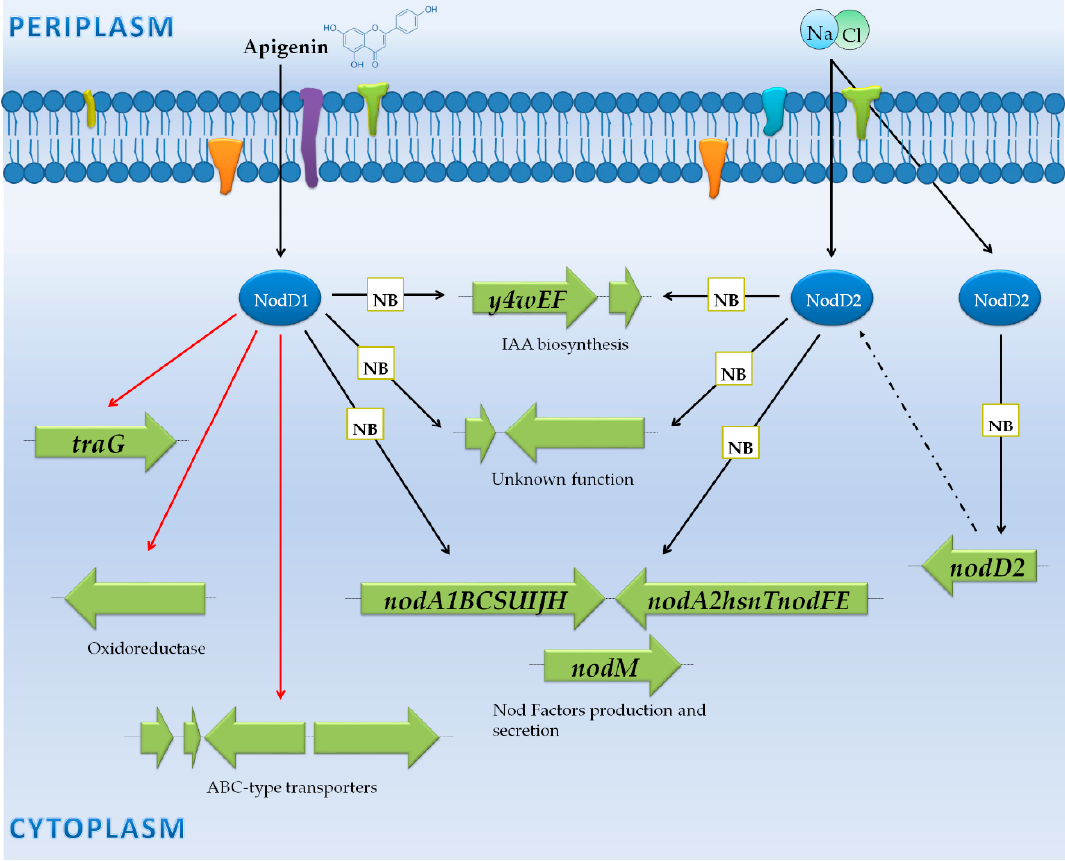
Figure 4. Transcriptomic response in the presence of apigenin and NaCl in R. tropici 899. Proteins are illustrated by blue circles. The DNA to protein translation process is represented by dotted arrows. Activation and repression of genes are indicated by black and red arrows, respectively. Genes regulated by a nod box are represented in green.